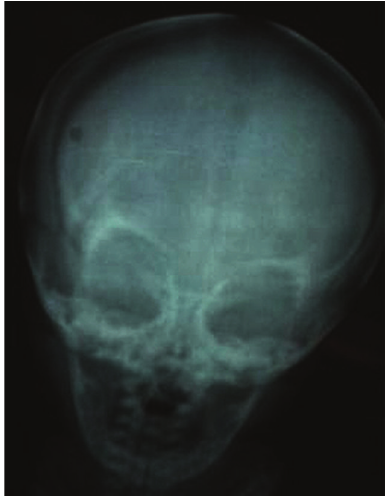
Figure 2: The frontal radiogram of the calvaria: increased perior- bital bone density and the typical “space alien”